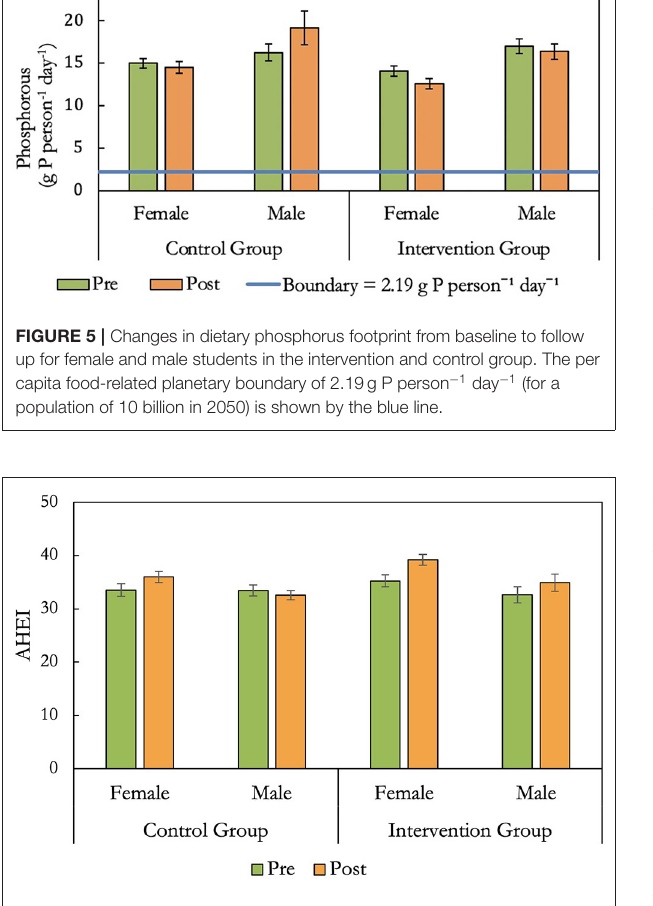
FIGURE 6 | A 50 point modified Alternative Healthy Eating Index (AHEI) at baseline and follow up for female and male students in the intervention and control